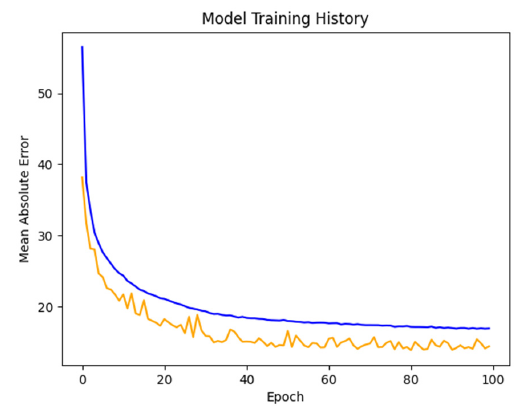
Table 3. Mean absolute error in a 5-fold cross-validation and in overall test set.